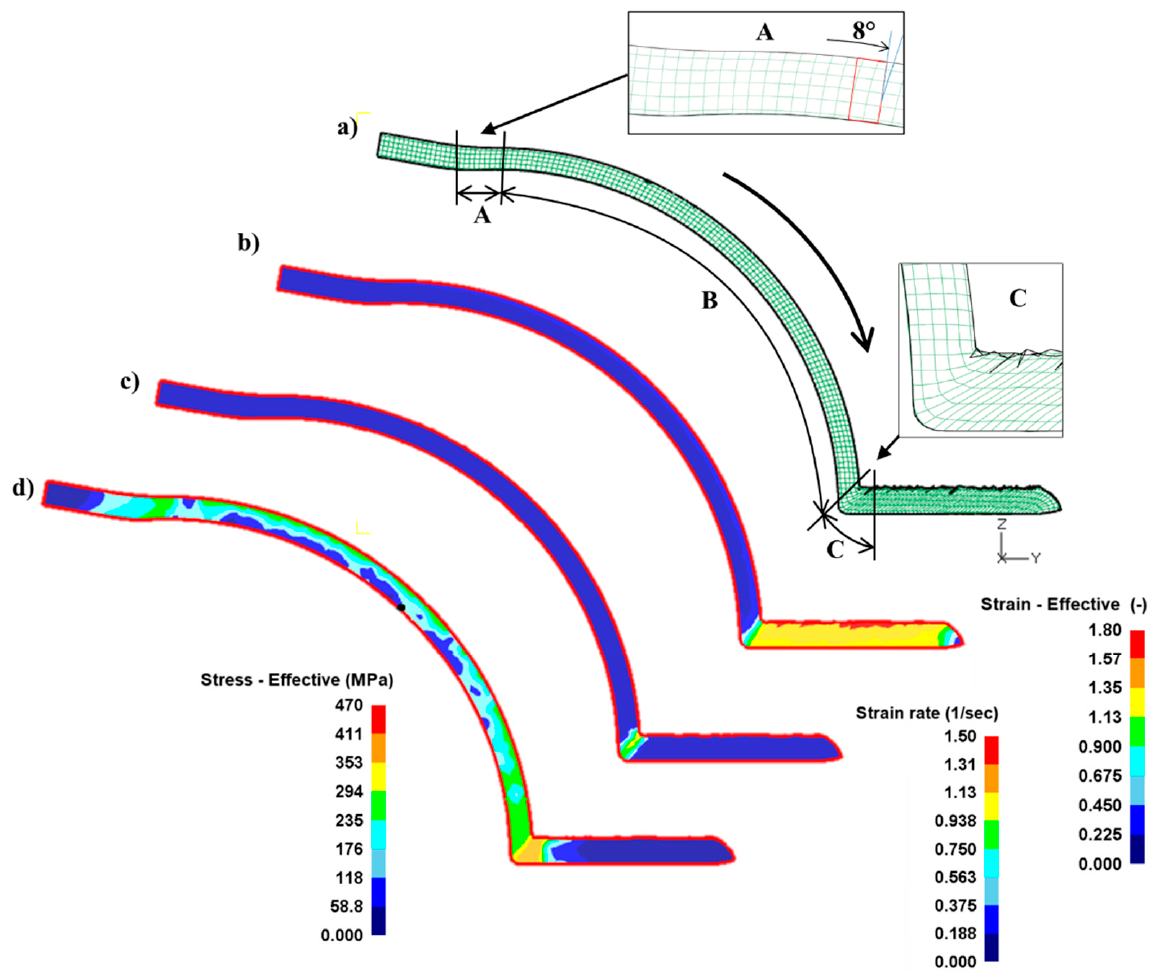
Figure 5. The distributions of: ( a ) the flow net; ( b ) effective strain; ( c ) strain rate effective; ( d ) stress effective in the ECAR process. The A, B, and C represent deformation zones: A—Shape Rolling, B—Upsetting, and C—SPD .